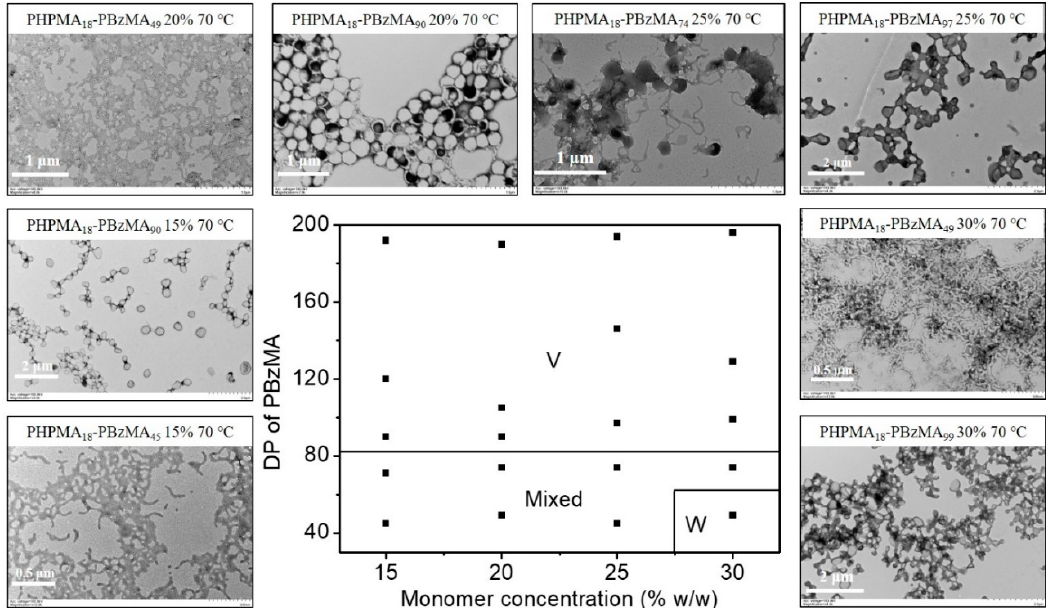
Figure 5. Representative TEM images and the morphological phase diagram for PHPMA 18 -PBzMA n diblock copolymers prepared by blue light-initiated alcoholic RAFT dispersion polymerization of BzMA at 70 °C. Phase areas consist of worms (W), mixed morphology (Mixed) and vesicles (V).